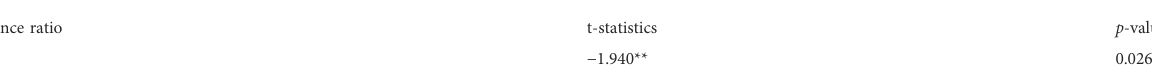
TABLE 10 The Westerlund test